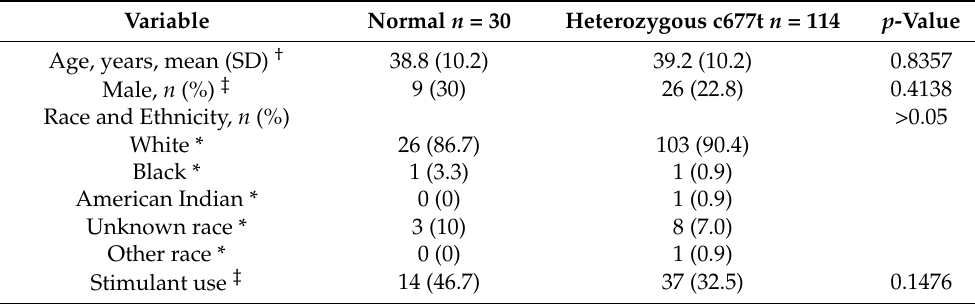
Table 3. Heterozygous C677T compared to those with a normal MTHFR allele.